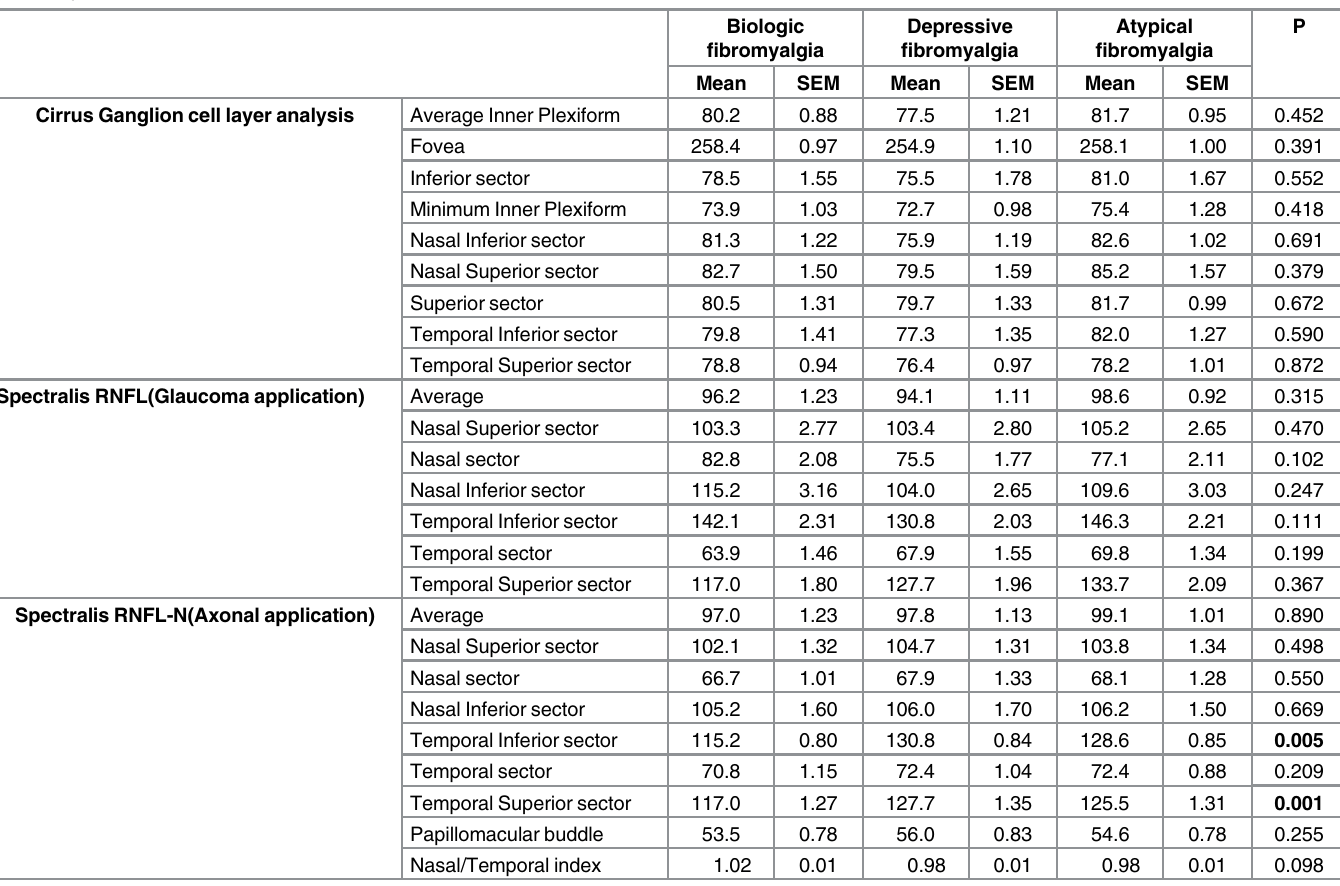
Table 4. Mean and standard error of the mean of retinal nerve fiber layer thicknesses obtained with the Cirrus and Spectralis optical coherence tomography devices in patients with biologic fibromyalgia (26 patients), depressive fibromyalgia (34 patients), and atypical fibromyalgia (56